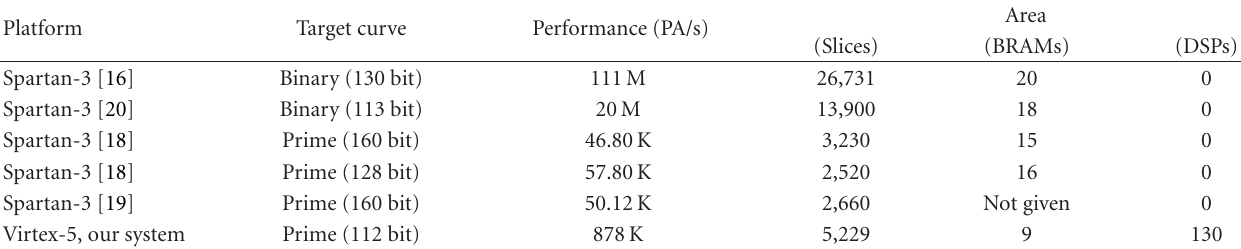
Table 4: Comparison with Hardware ECDLP implementations (per